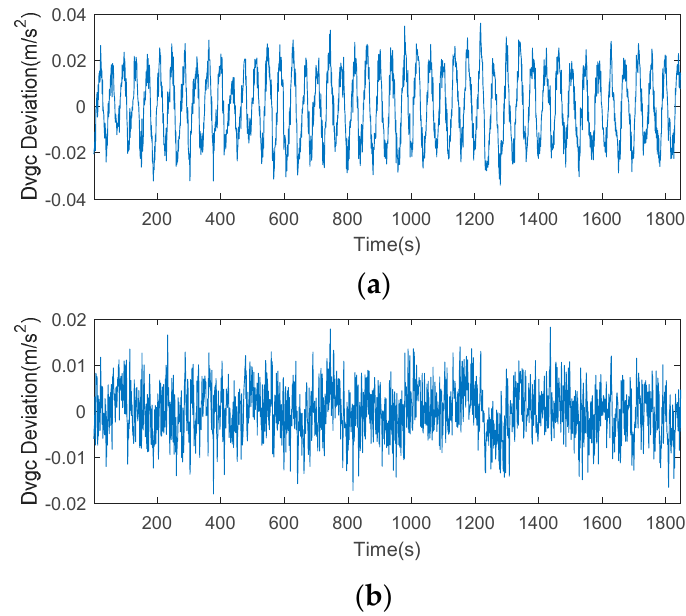
Figure 20. ( a ) CMCD (Time averaging, 100 epochs) in the time domain comparison before the adaptive frequency domain filter, R20, ( b ) CMCD (Time averaging, 100 epochs) in the time domain comparison after the adaptive frequency domain filter, R20.